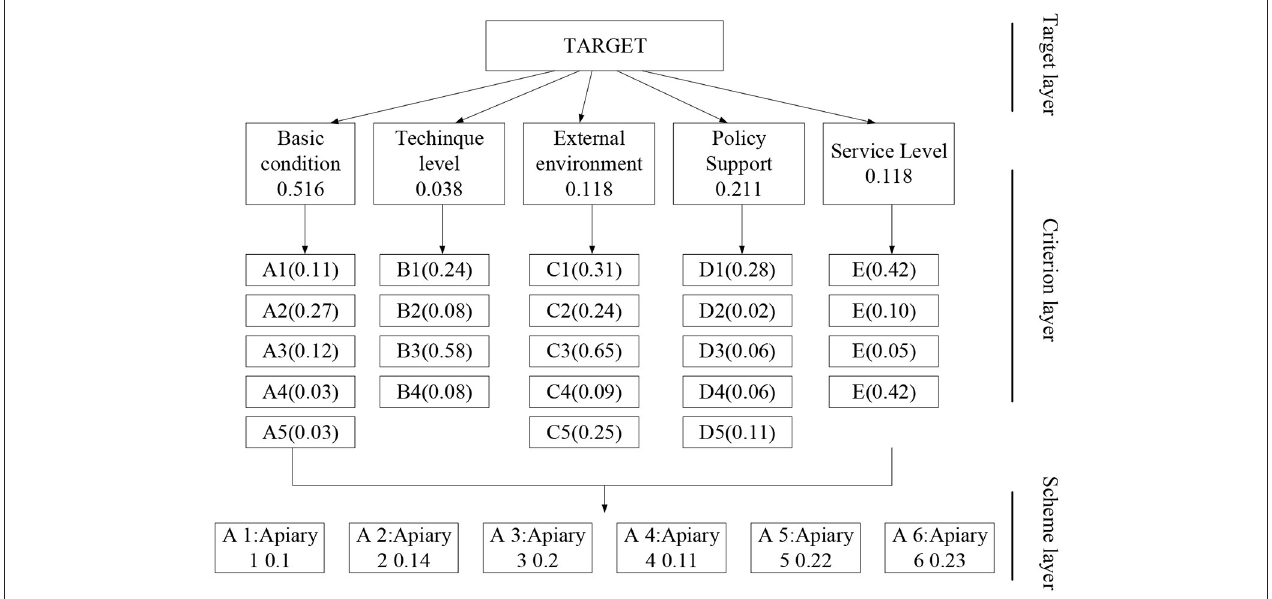
FIGURE 5 | The AHP structure of Macau’s tourism industry.